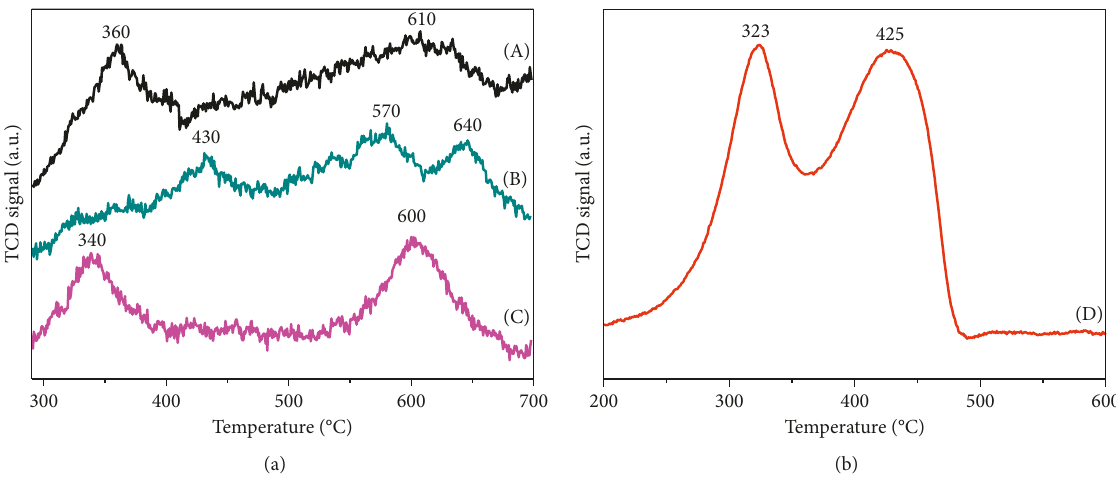
Figure 3: H 2 TPR profiles of MnLUS (7 wt.%) catalysts: (A) MnLUS DHT , (B) MnLUS Imp , (C) MnLUS TIE , and (D) MnLUS SSI